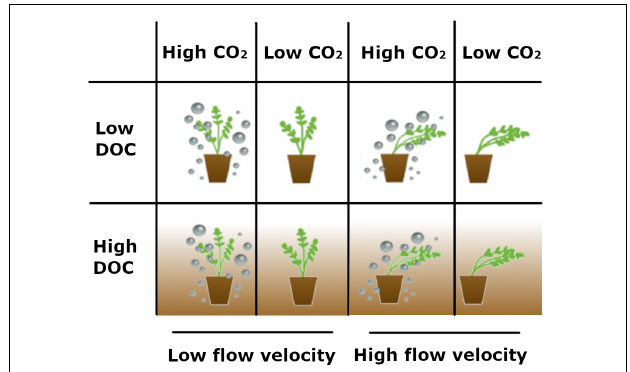
FIGURE 1 | Schematic overview of the experimental setup. The experiment was carried out in four flumes with each their own combination of treatments: high CO 2 × low flow velocity, low CO 2 × low flow velocity, high CO 2 × high flow velocity, and low CO 2 × high flow velocity. This experiment was then repeated with the same treatments, but this time DOC was added to all